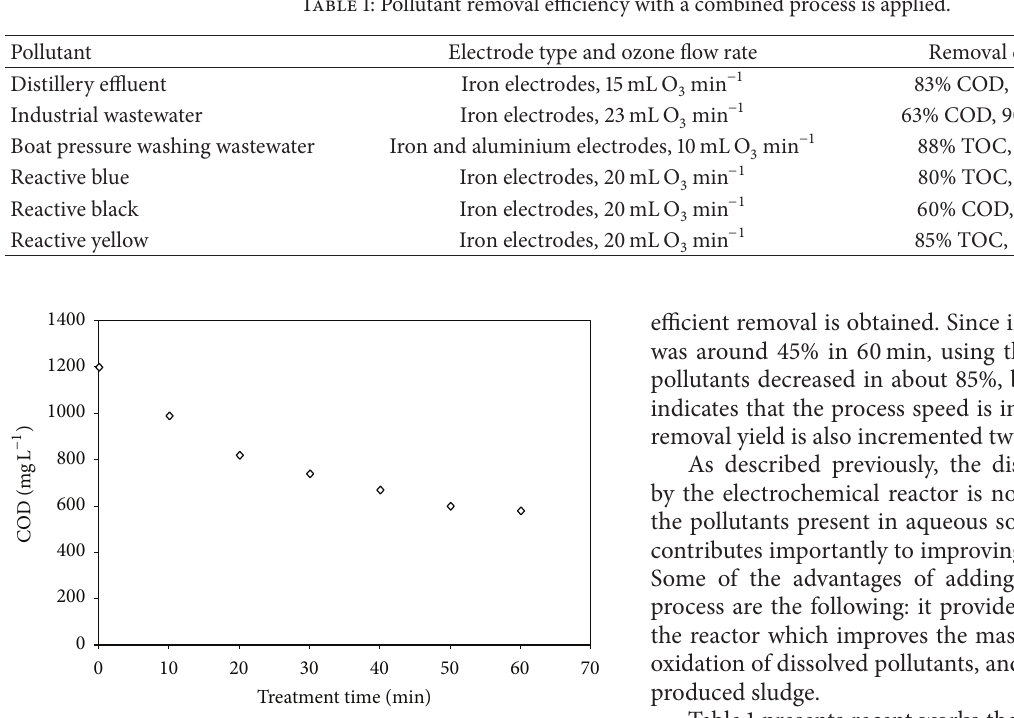
Figure 3: COD abatement as a function of treatment time using ozone. The initial pH was 7.3.